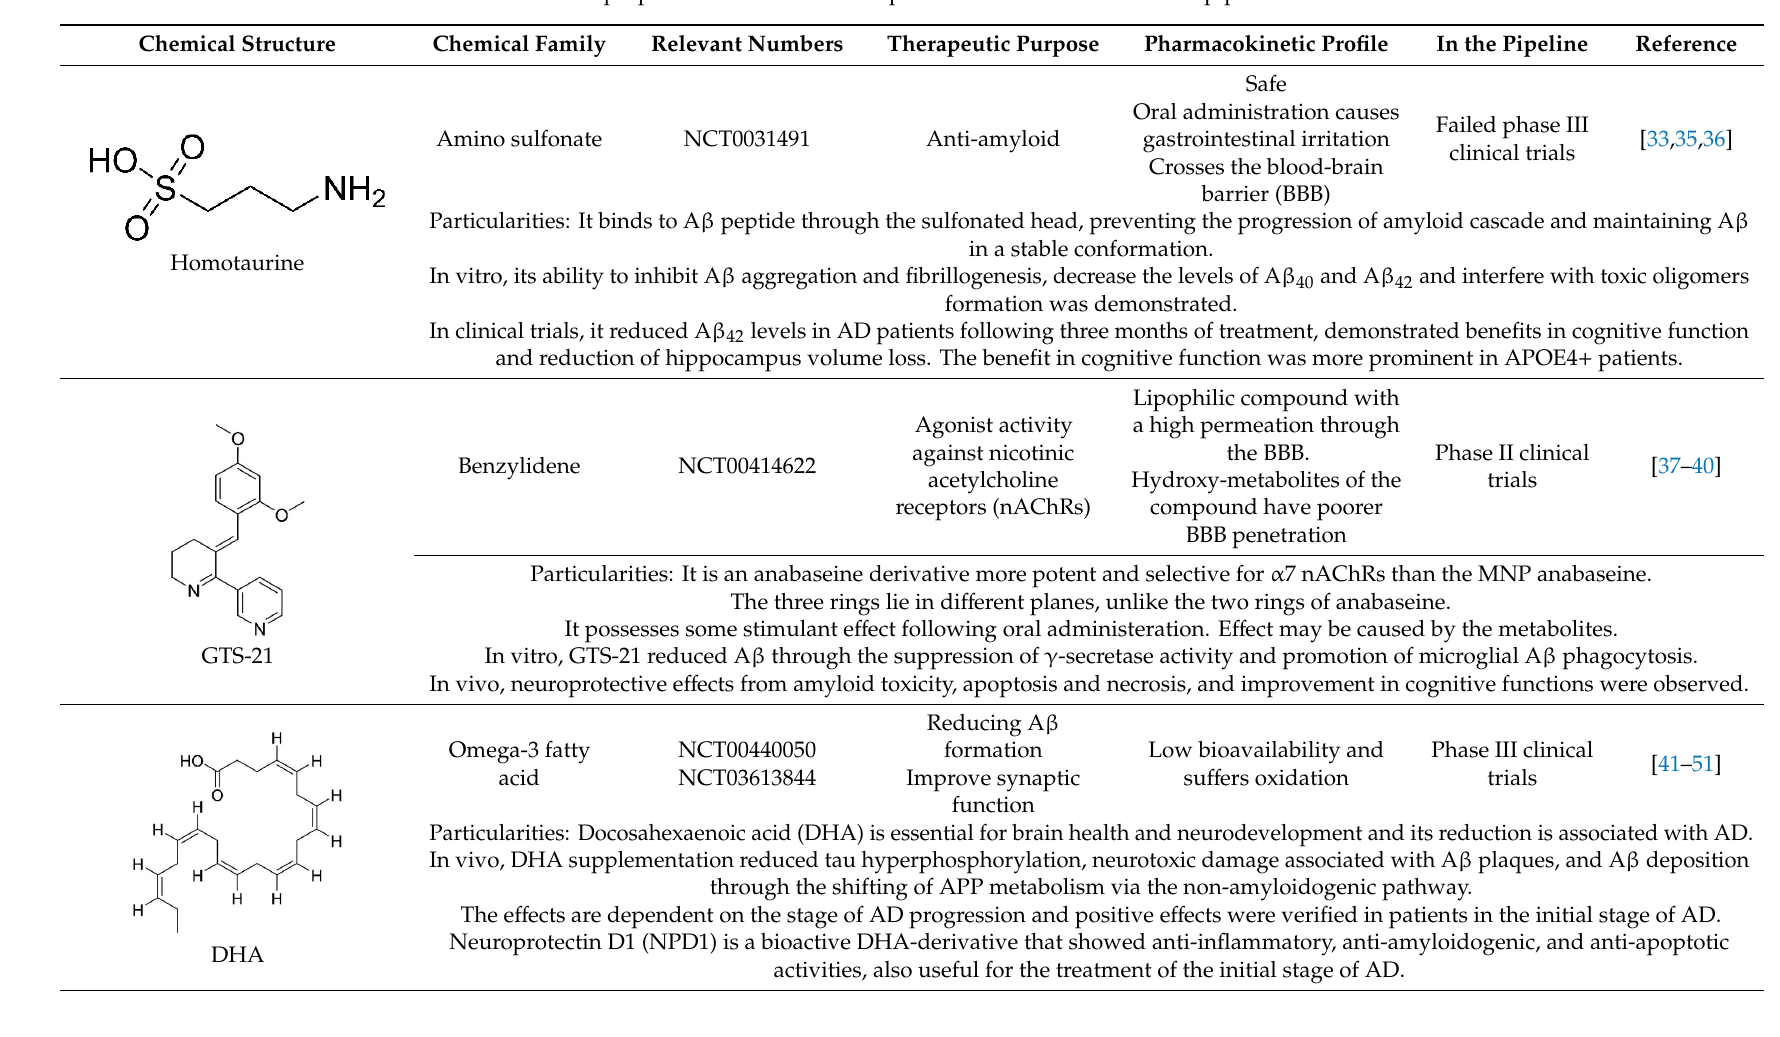
Table 1. List of the main properties of marine natural products and derivatives in the pipeline for AD treatment.